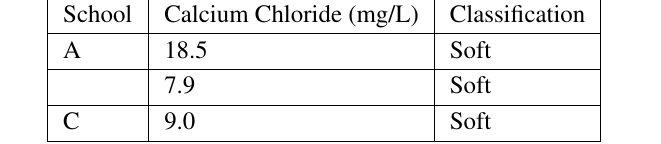
Table 4. Hardnesstest result (concentration of CaCl) of water samples from WVMs